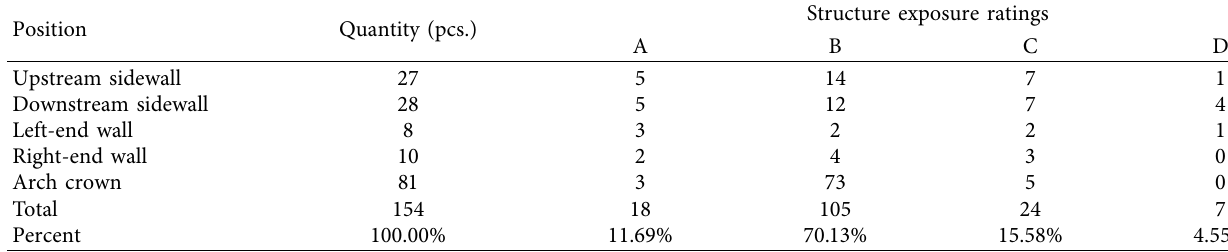
Table 9: Exposure ratings of the anchor head